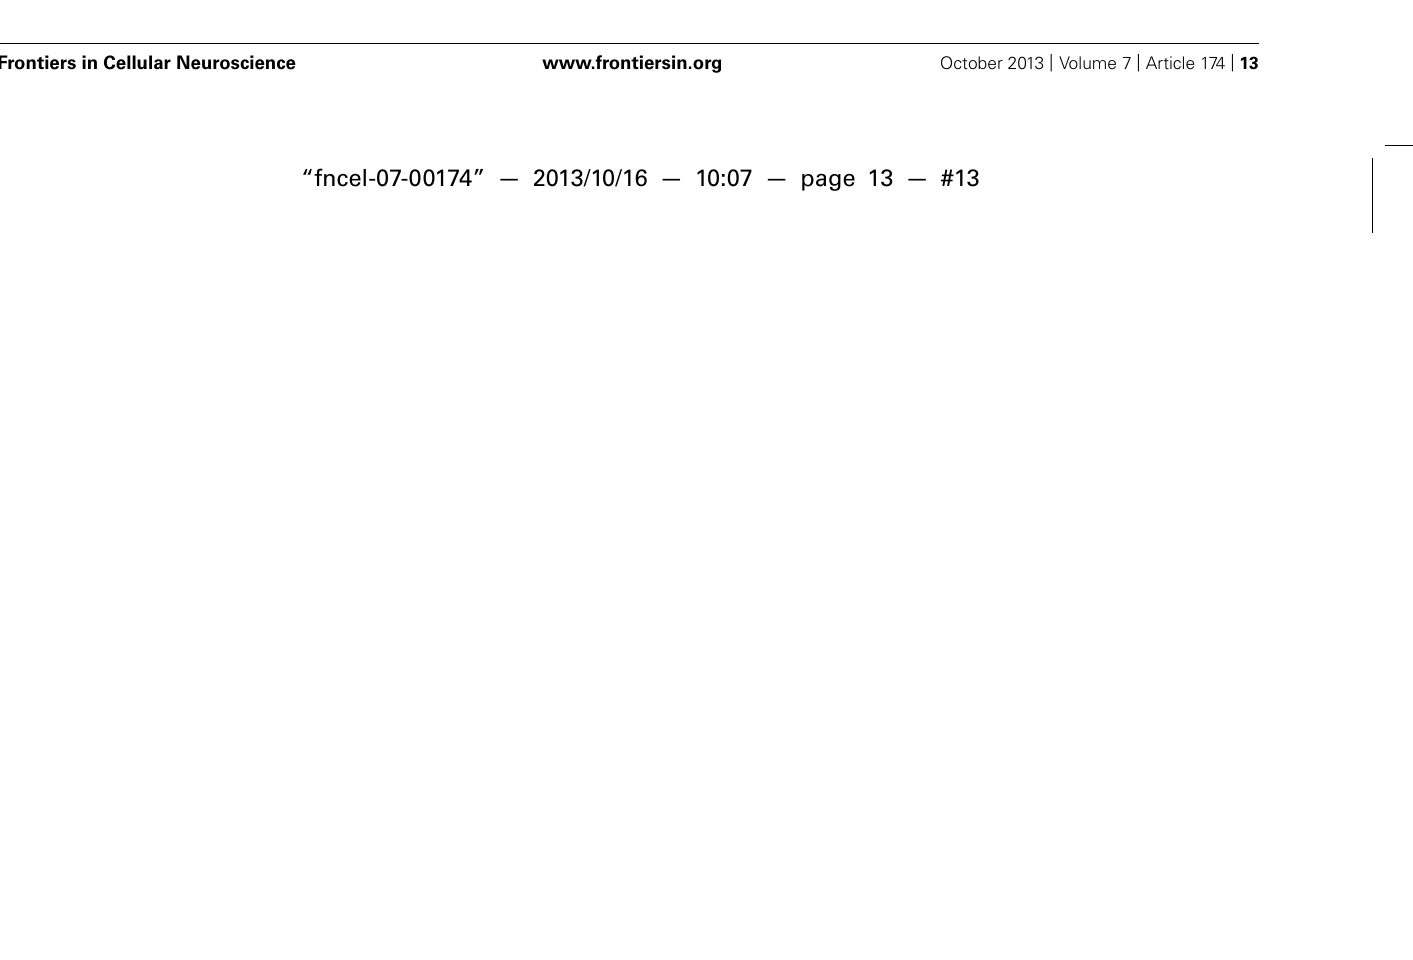
indicated in gray, filled and open squares respectively for lumbar and cervical CSp neurons). Horizontal gray bars indicate group-wise differences at the 5% significance level ( B, D , one-way ANOVA and Tukey’s post hoc test; C , Kruskal-Wallis test and Dunn’s post hoc analysis). (F–H) Comparison of the same parameters at 26 and 36 ◦ C for paired recordings. Relationship between action potential half width and maximum rise at 26 ◦ C (E) and 36 ◦ C (I) , highlighting the fastest rising shortest duration of the action potential in the CTh